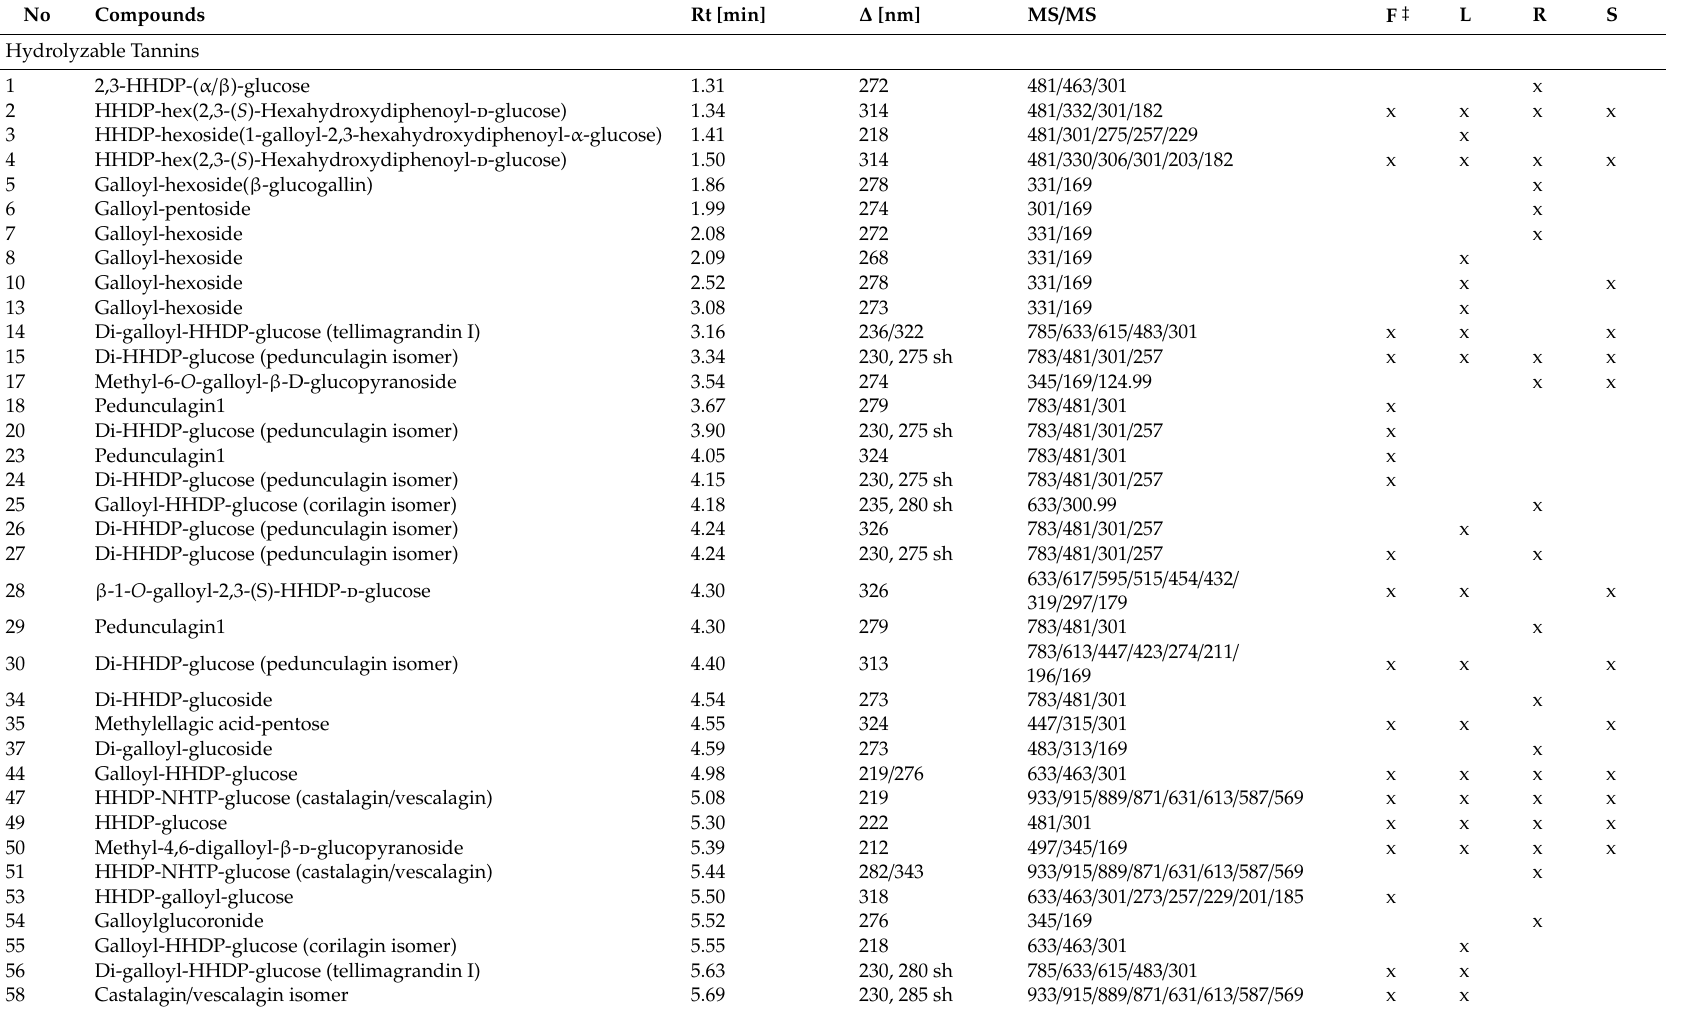
Table 1. Characterization of polyphenolic compounds in Sanguisorba o ffi cinalis L. by LC-DAD-ESI-QTOF-MS /